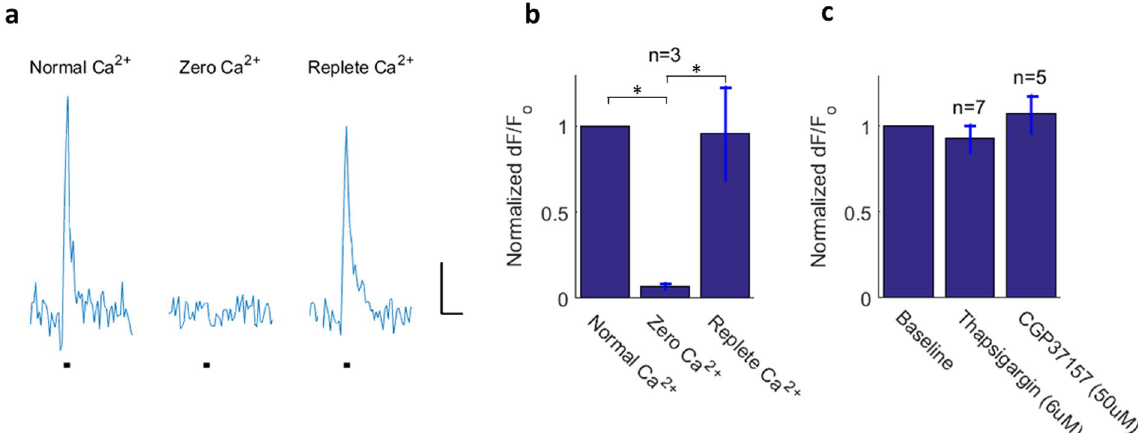
Figure 5. Extracellular calcium removal causes abolishment of axonal calcium-fluorescence transients. ( a ) Nodal calcium response to 20 action potential bursts (100 Hz) in normal calcium, zero-calcium, and replete calcium. Single sweep recordings are shown. Scale bar: 1 s & 3% fluorescence change . ( b ) Results are summarized for three independent experiments indicating unequal means between normal calcium and zero calcium states (p = 0.014) and between zero calcium and replete calcium states (p = 0.017) (ANOVA with Tukey-Kramer test for multiple comparisons, F = 11.04, df = 6). ( c ) Application of the ER Ca 2 + -ATPase blocker thapsigargin (6 μ M) and the mitochondrial Na/Ca exchanger blocker CGP37157 (50 μ M) did not significantly reduce activity- dependent nodal calcium amplitude.